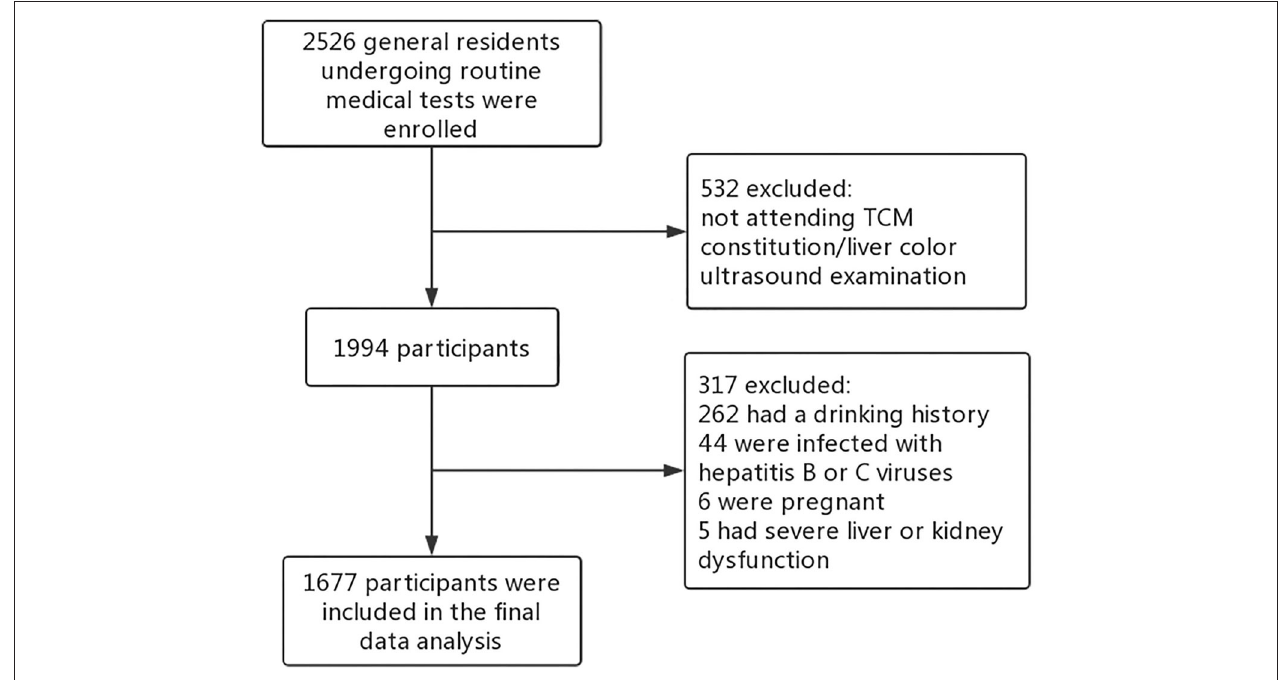
FIGURE 1 | The flow chart of the study sample selection.